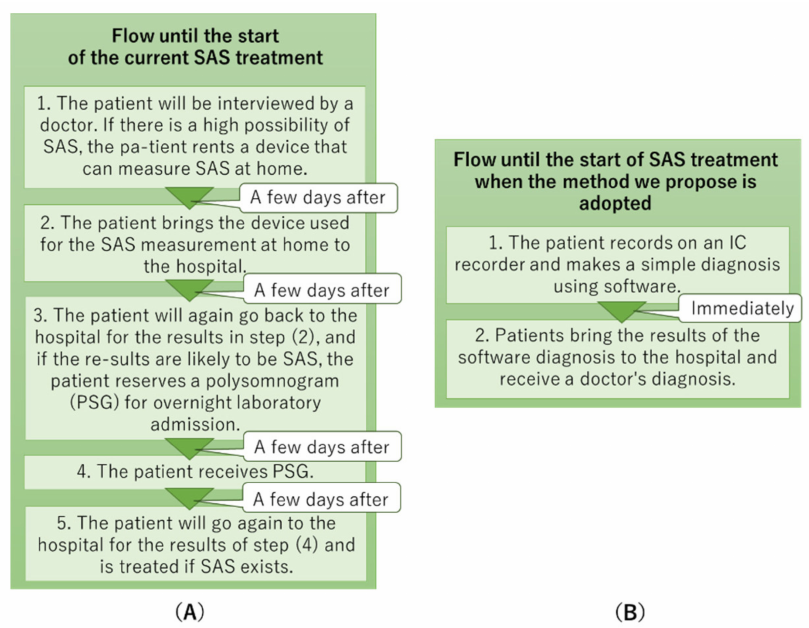
Figure 1. Step comparison of SAS diagnosis: ( A ) current medical institutions and ( B ) proposed procedure.